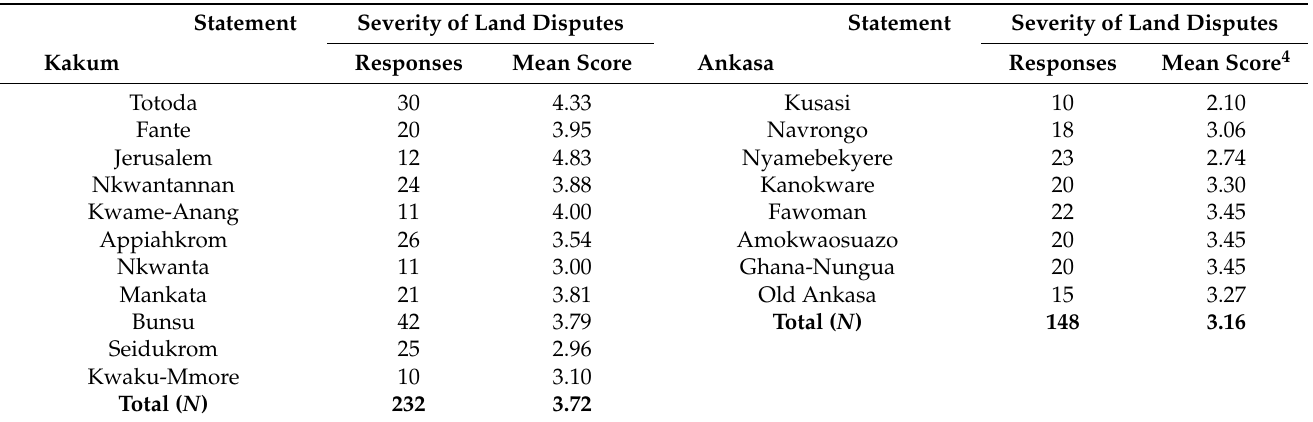
Table 1. Severity of land disputes in the surveyed communities.